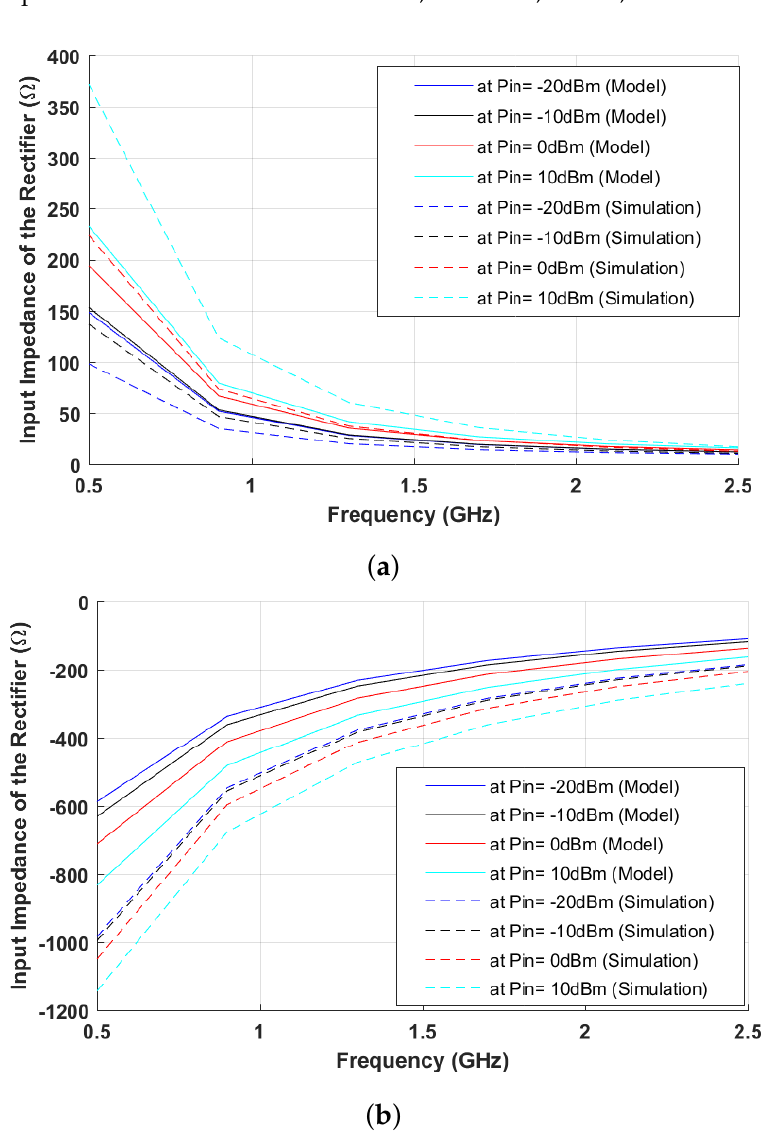
Figure 2. Modelling results of input impedance of the rectifier vs. frequency at different input power levels. ( a ) Real part. ( b ) Imaginary part.